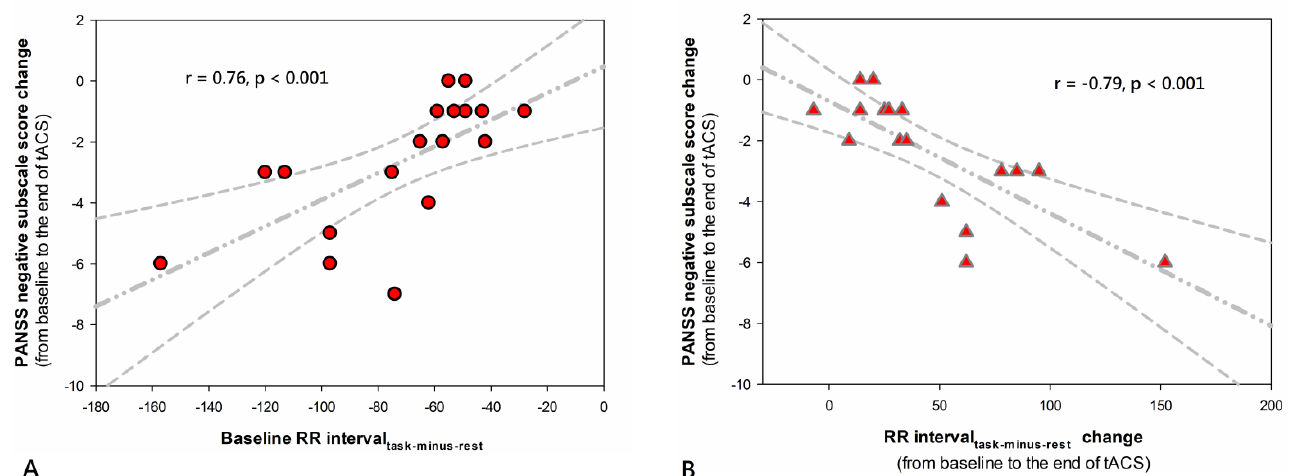
Figure 5. Correlation analyses in patients treated with active online theta-tACS showed that ( A ) more negative values of baseline RR interval task-minus-rest were associated with greater reductions in PANSS negative subscale score from baseline to the end of stimulation, and ( B ) increases in RR interval task-minus-rest from baseline to the end of stimulation were associated with greater decreases in PANSS negative subscale scores during the same period. RR interval task-minus-rest represents RR intervals during dual 2-back tasks minus RR intervals during resting conditions (ms). The regression line and 95% confidence intervals for the linear regression slope are shown.